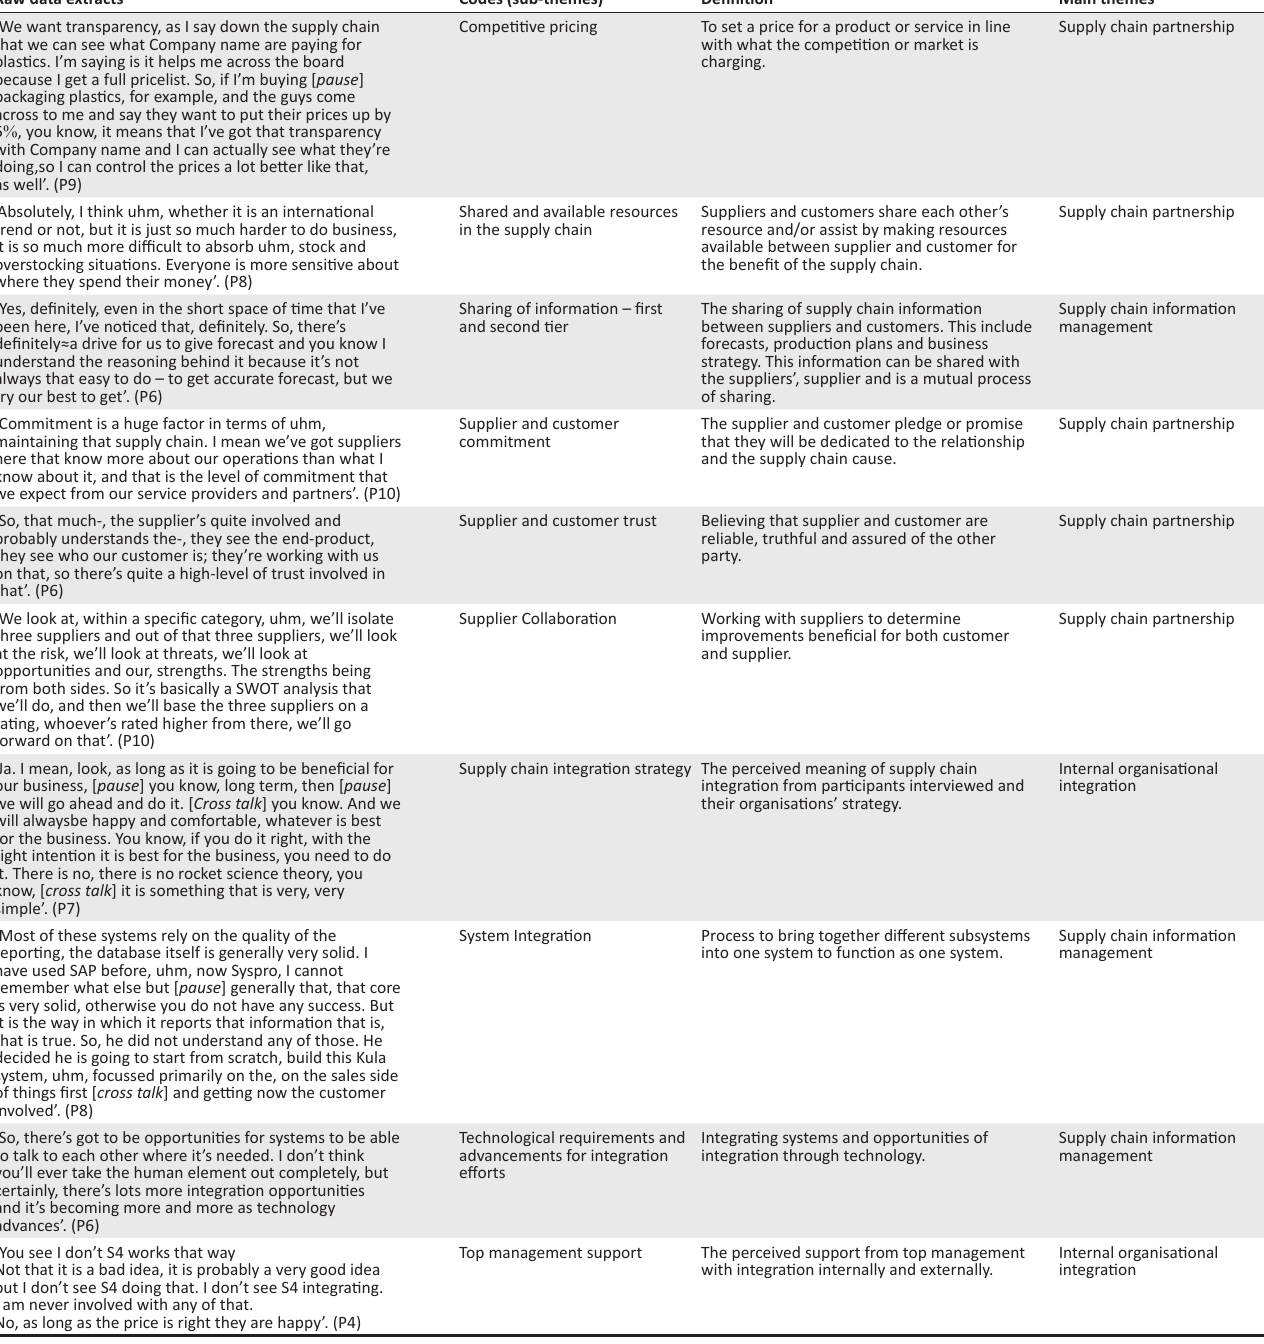
TABLE 1-A2: The link between the codes (sub-themes) and main themes identified in this study. Raw data